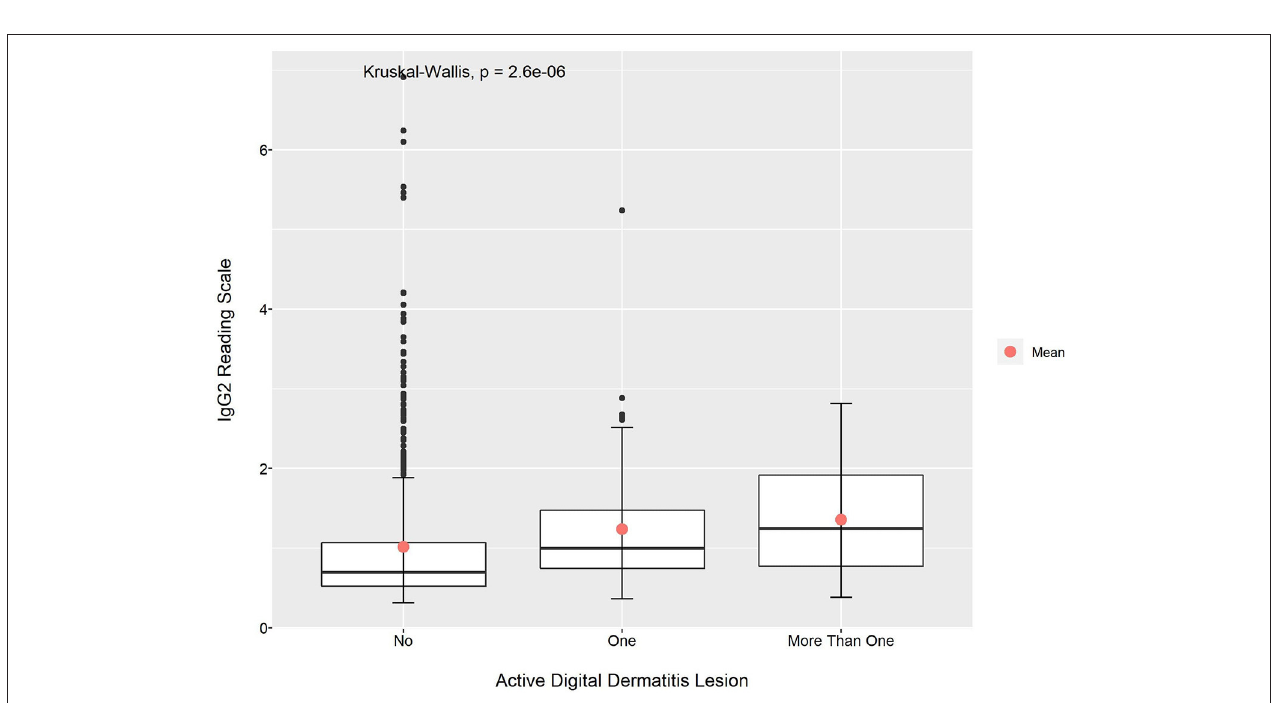
FIGURE 4 | Mean absorbance reading for IgG2 anti- Treponema antibodies according to the presence of active DD lesion.